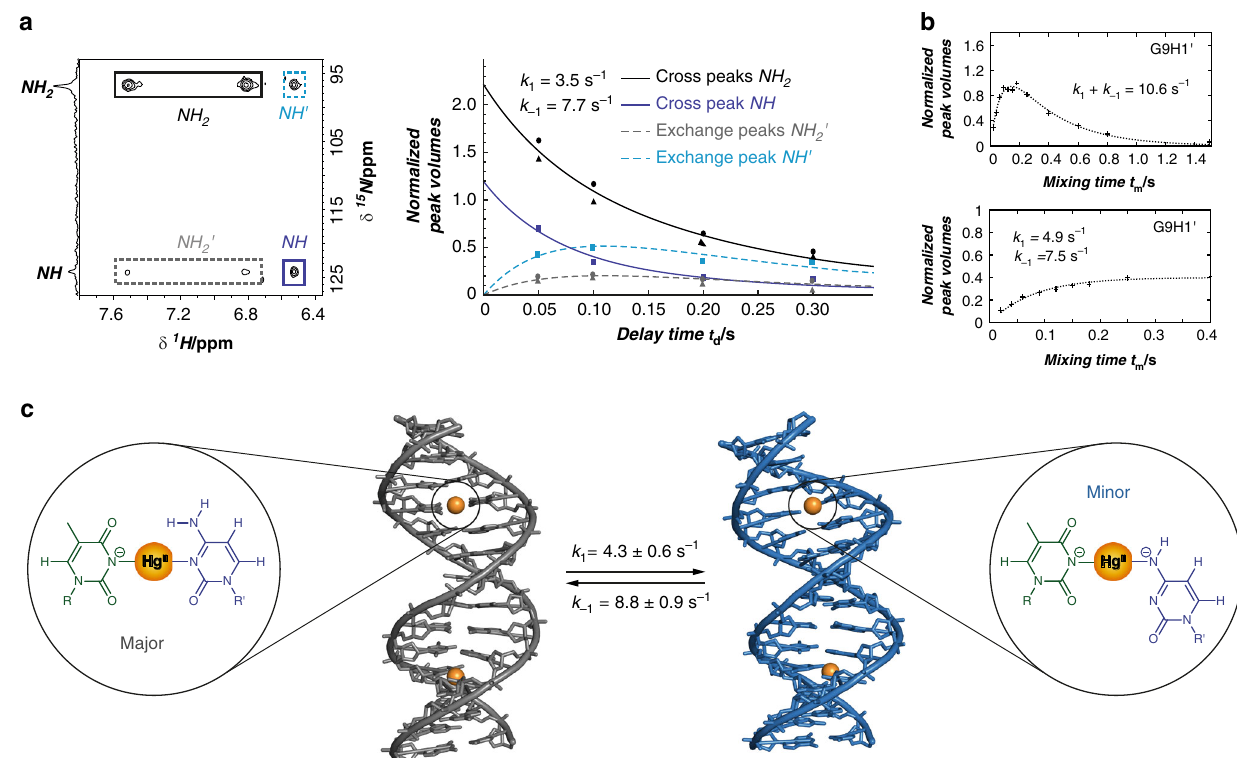
Fig. 7 Dynamic isomerization of duplex DNA containing two C-Hg II -T base pairs. a Dynamic changes in local metal ion coordination. Rate constants of interconversion were determined by plotting changes in cross peaks ( NH 2 and NH ) and exchange cross peaks ( NH 2 ' and NH' ) observed in z-z exchange [ 15 N, 1 H]-HSQC spectrum as a function of different delay times. Rate constants of interconversion were determined by global fi tting of integrated peak volumes versus exchange delay times using Supplementary Equations 6-9, where R 1 , k 1 , and k -1 were constrained as being equal for all four curves with the assumption that all proton- and nitrogen atoms have the same relaxation rate ( R 1 ) and that the NH proton is converted equally to both NH 2 protons during the exchange. b Representative example (G9H1') of duplex interconversion rate constants as determined by monitoring changes in exchange cross peaks and exchange-mediated NOE cross peaks in [ 1 H, 1 H]-NOESY spectra with various mixing times (t m ). At longer mixing times, a decrease in signal intensity was observed due to auto relaxation ( R 1 ). The sum of interconversion rate constants ( k 1 + k -1 ) was determined by fi tting changes in cross peak intensity vs mixing time (t m ) (Supplementary Equation 12). The individual rate constants of interconversion ( k 1 and k -1 ) were determined by fi tting (Supplementary Equation 14) cross peak intensities normalized by the intensities of diagonal peaks versus mixing times. See Supplementary Figs. 37, 38 for [ 1 H, 1 H]-NOESY spectra, and Supplementary Figs. 39 – 42 for the same types of analyses at other positions. c Summary of major- and minor duplex structures, structures of the metallo base pairs they contain, and the rate constants of their exchange. Rate constants values are given as mean ± standard deviation from 5 exchange cross peaks and exchange-mediated NOE cross peaks. The Hg II -ligand complexes present in the major species are net positive ( + 1), whereas those of the minor species are neutral. The combined contributions of more favourable electrostatic interactions and near-canonical B-form helical structure present in the major species likely outweigh the stronger ligand – metal – ligand binding interactions present in the minor